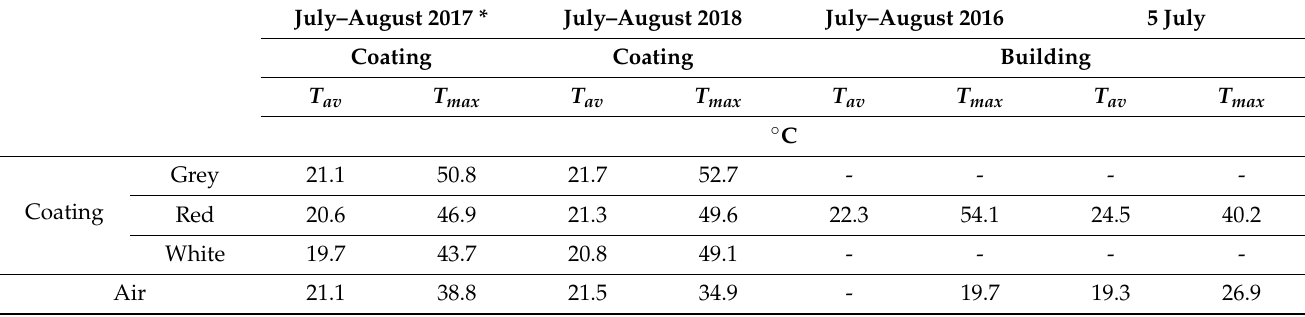
Figure 6. Surface temperature (N_45°) for the period of 1 July to 31 August 2016. Table 2. Average and maximum surface temperatures of the partition for the period of July–Au- gust.